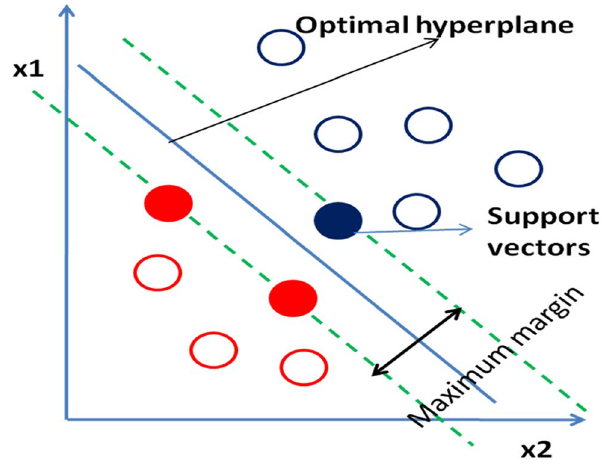
Figure 5. Hyperplane (blue line) representation in SVM. Red and blue circles represent data points from two different classes. Solid filled circles denote support vectors.